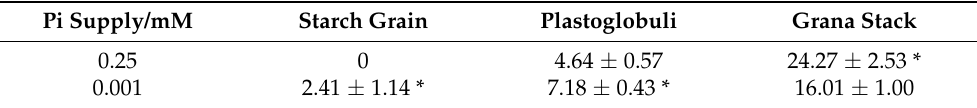
Figure 6. Representative electron micrographs of chloroplasts taken from the intact leaves of P 0.25 ( A – C ) and P 0.001 ( D – F ). CW, cell wall; GT, grana thylakoid; ST, stroma thylakoid; SG, starch granule; P, plastoglobuli. The scales for the mesophyll cells ( A , D ), the chloroplast ( B , E ), and the enlarged parts ( C , F ) are 2 µ m, 1 µ m, and 200 nm, respectively. Table 1. The number of starch grain, plastoglobuli, and grana stacks per chloroplast under the different Pi treatments. The values represent the mean ± SD ( n > 30) and the asterisks indicate the significant differences according to Tukey’s test using a one-way ANOVA (* p <